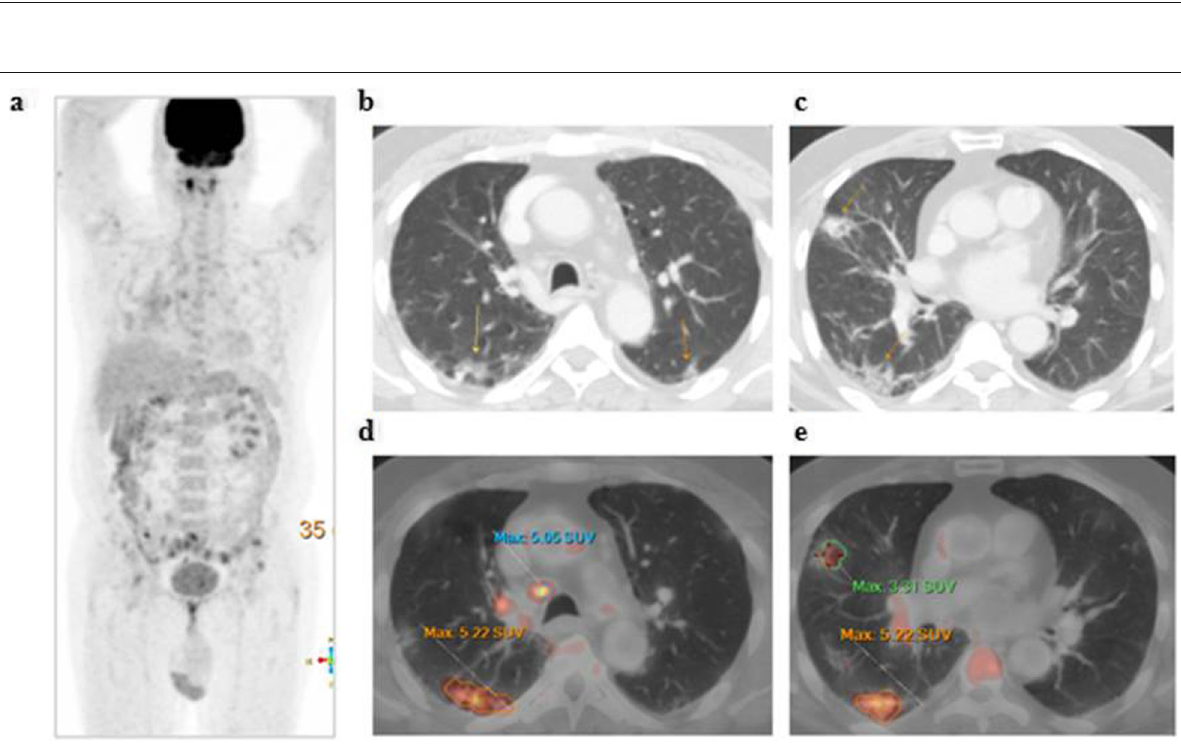
Fig. 5 A 62-year-old male patient, with a history of surgically resected rectal cancer and referred for PET/CT follow-up. The whole-body MIP image ( a ) shows bilateral pulmonary metabolically active areas. Axial lung window CT images ( b , c ) revealed bilateral subpleural variable-sized ground-glass opacities with consolidation that show variable FDG avidity on corresponding fused PET/CT images ( d , e ) achieving up to 5.2 SUVmax